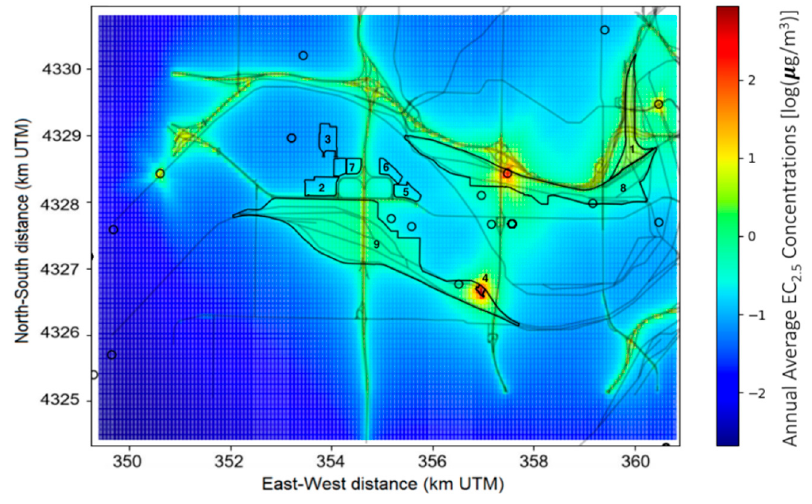
Figure 6. Modeled annual average EC 2.5 concentrations. Note: numbers indicate locations of 9 main area sources (1—Armstrong Rail Yard, 2—Associated Wholesale Grocers, 3—USPS Distribution